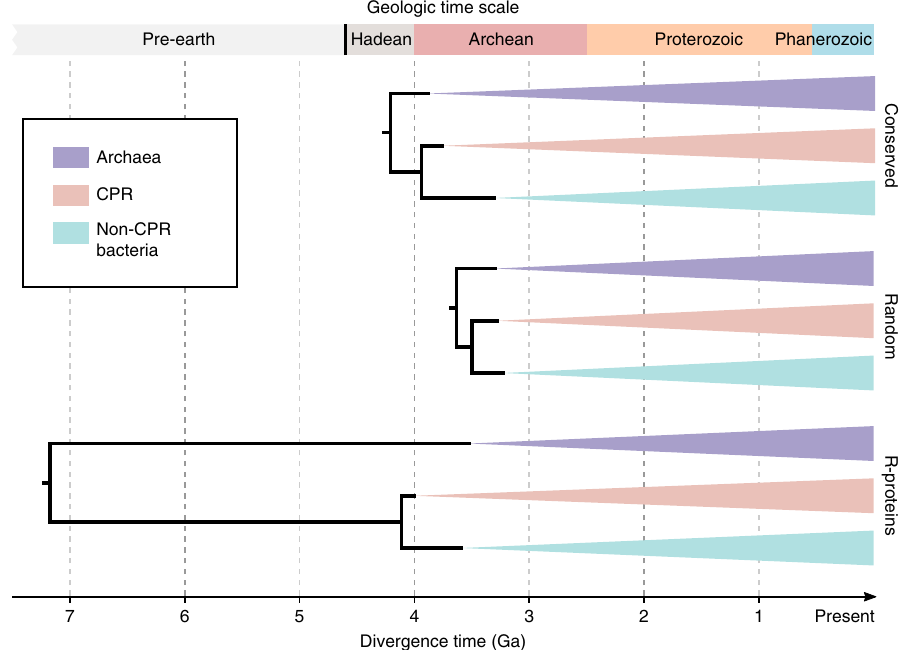
Fig. 6 Estimated ages of basal diversi fi cations. Divergence time estimation was performed using maximum likelihood based on the ASTRAL tree topology with branch lengths estimated using most conserved or randomly selected sites from the 381 global marker genes, or using the 30 ribosomal proteins. A universal clock was assumed. The Cyanobacteria/Melainabacteria split was constrained to 2.5 – 2.6 Ga. The best estimates from ten technical replicates per setting are displayed (see Supplementary Table 8). Details and alternative results of divergence time estimation are elaborated in Supplementary Note 6. Source data are provided as a Source Data fi